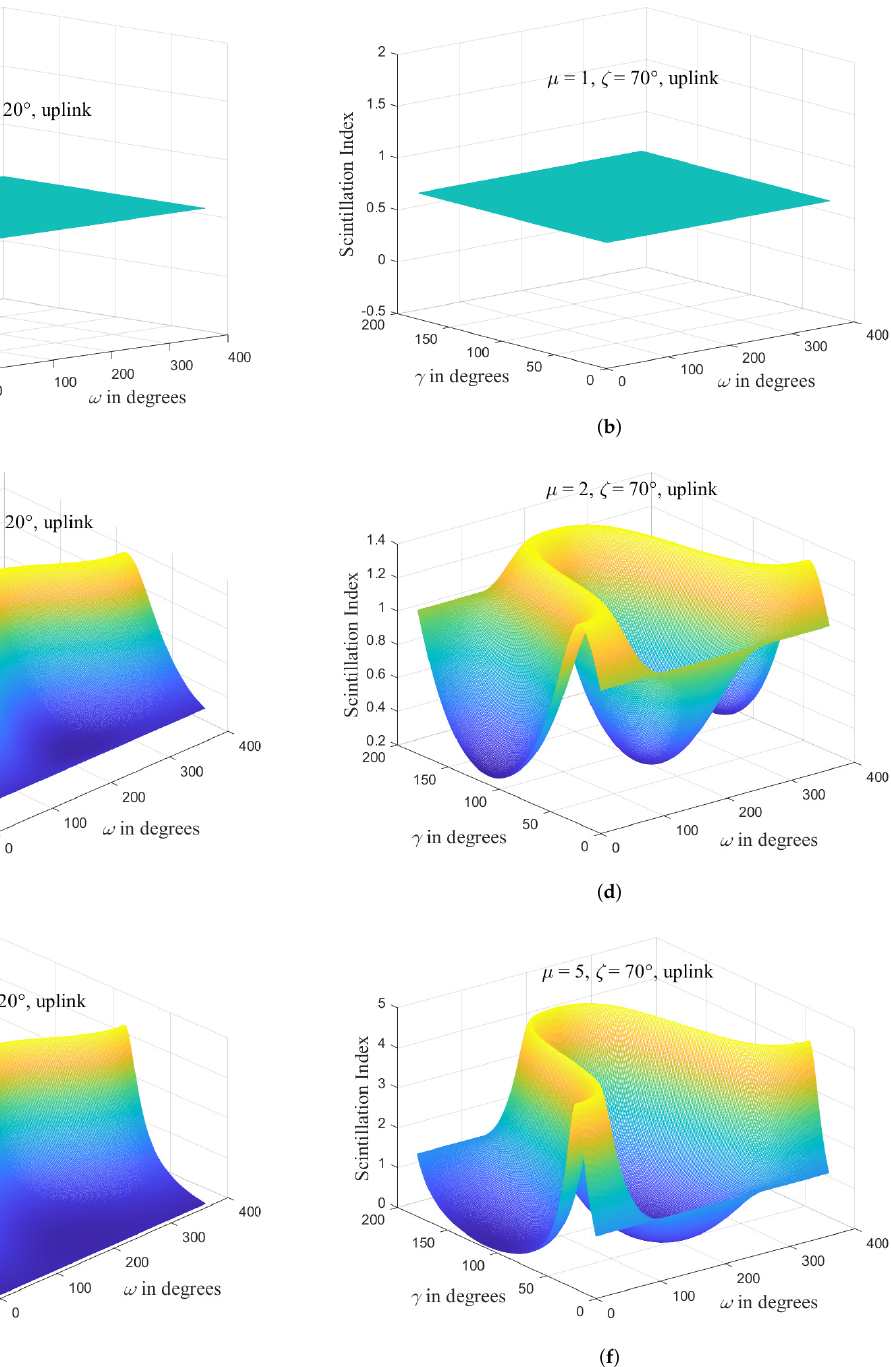
Figure 4. Scintillation index of uplink as the function of anisotropic tilt angle γ and azimuth angle ω for several values of zenith angle ζ and anisotropic factor µ , with ( a ) for µ = 1 and ζ = 20 ◦ , ( b ) for µ = 1 and ζ = 70 ◦ , ( c ) for µ = 2 and ζ = 20 ◦ , ( d ) for µ = 2 and ζ = 70 ◦ , ( e ) for µ = 5 and ζ = 20 ◦ , and ( f ) for µ = 5 and ζ = 70 ◦